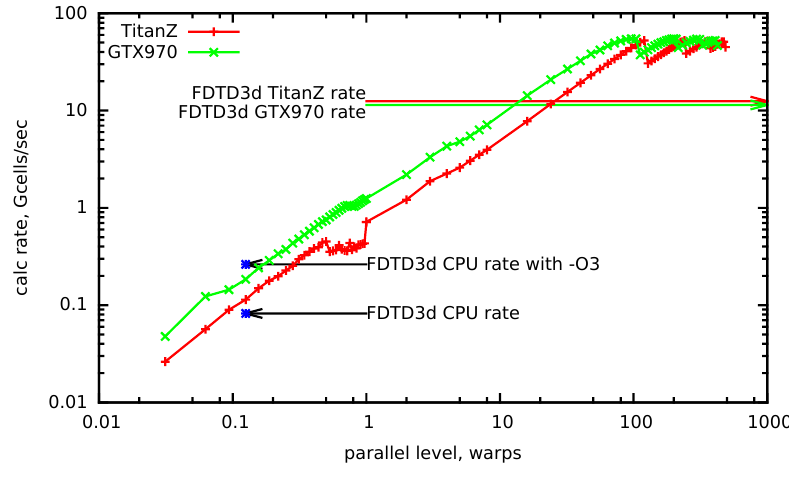
Figure 10. Strong scaling for the wave equation. DTS = 6, Nt = 96, N O =